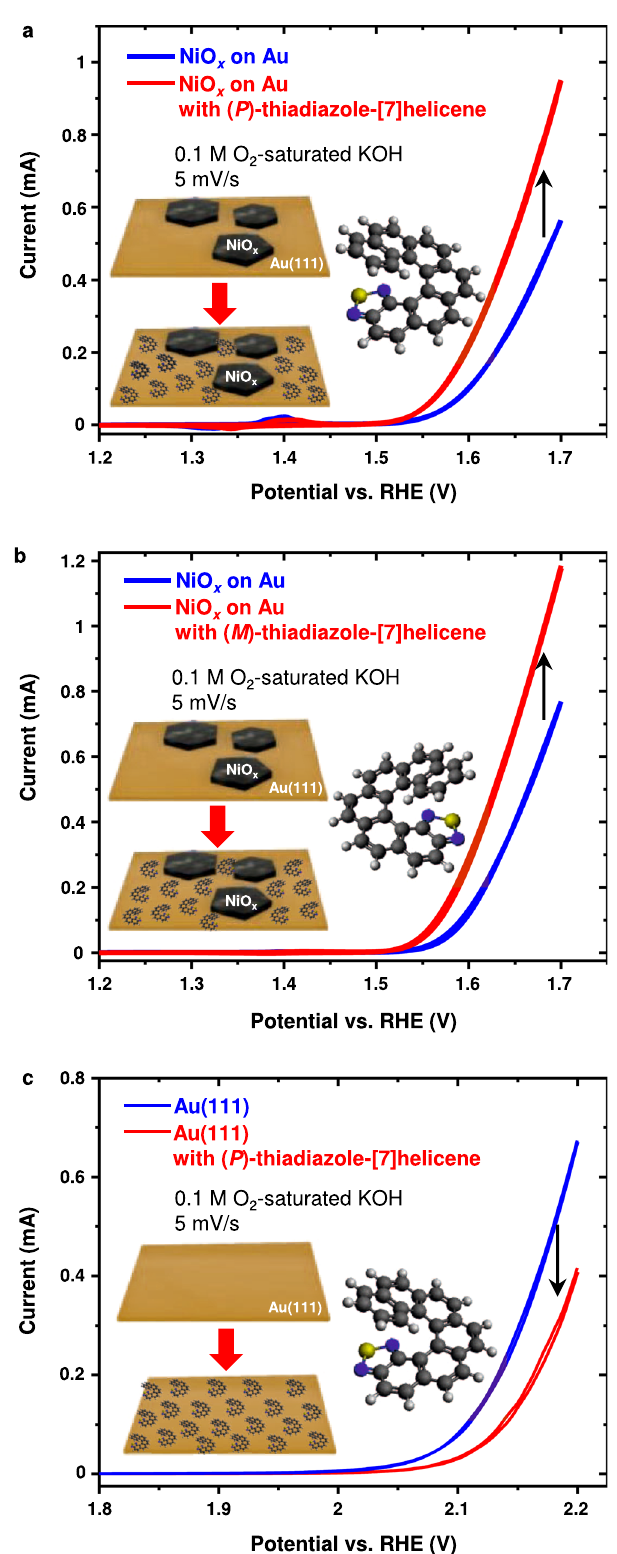
Fig. 1 Helicene enantiomer functionalization effect on the OER activity. OER activity of a ( P )-thiadiazole-[7]helicene embedded NiO x electrodes, b ( M )-thiadiazole-[7]helicene embedded NiO x electrodes, and c ( P )- thiadiazole-[7]helicene functionalized Au(111) in 0.1 M O 2 -saturated KOH. Source data are provided as a Source Data fi